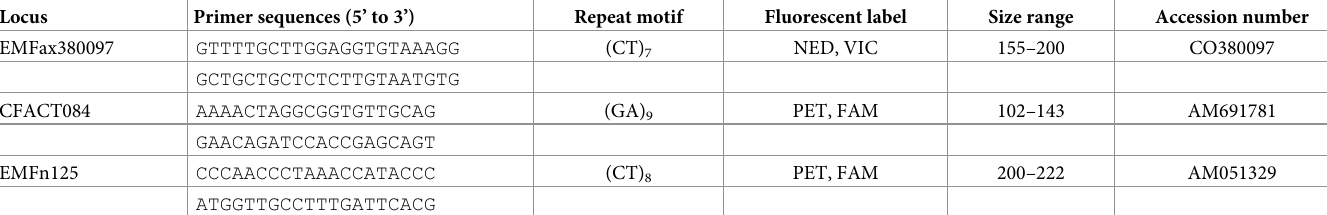
Table 1. Characterisation of three polymorphic microsatellite loci used to determine paternity of strawberry seeds [19, 20].